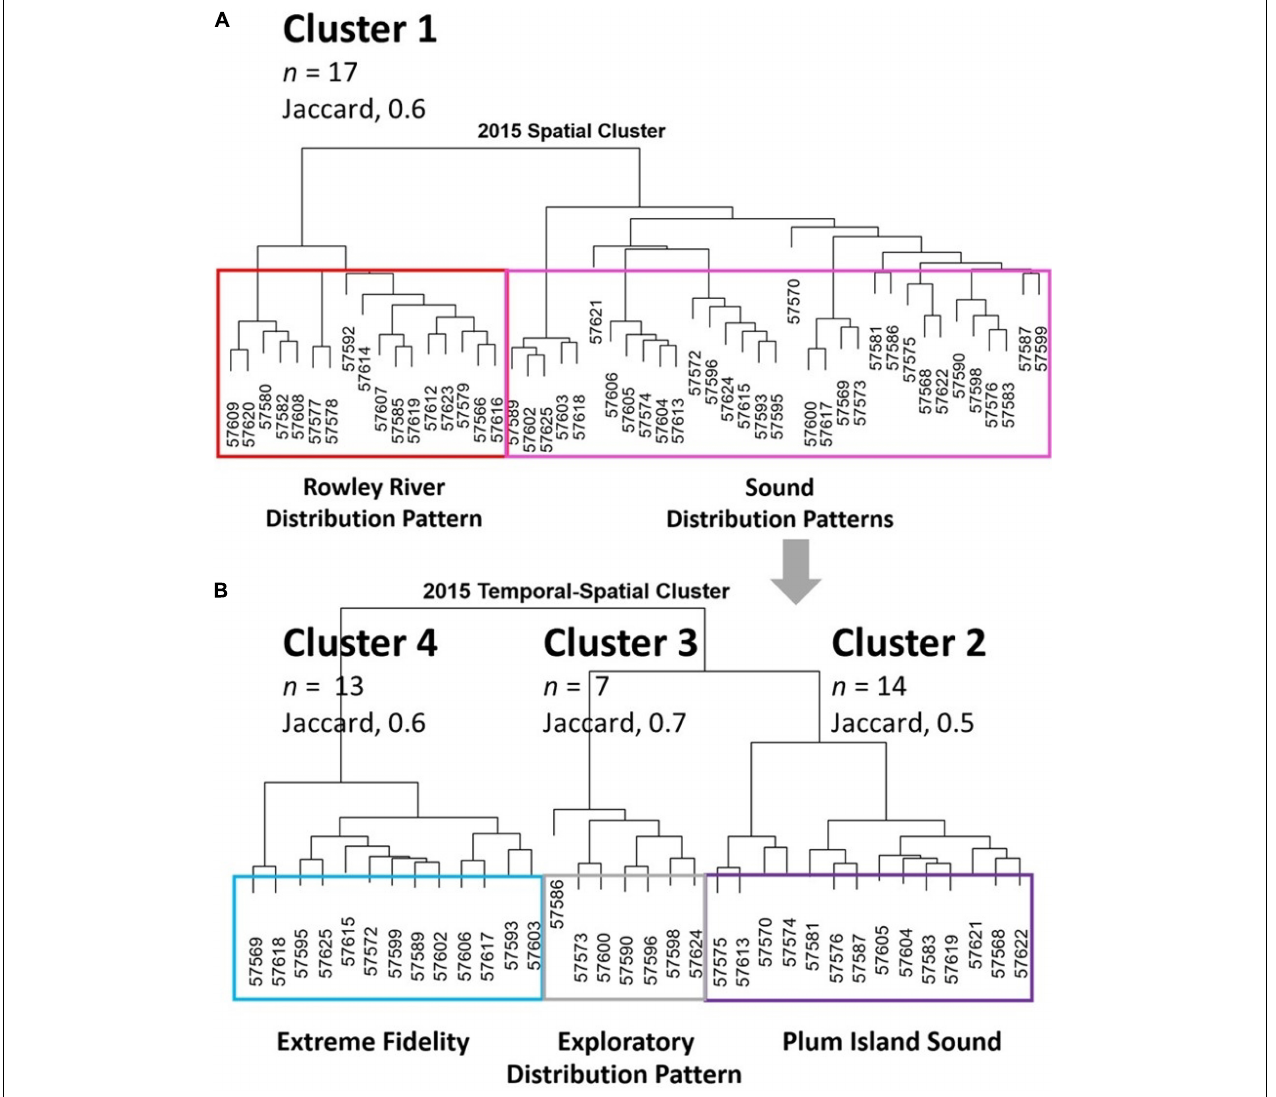
FIGURE 2 | Four distributional cluster groups are shown. (A) Spatial cluster dendrogram based on proportion of time spent at each of 26 receivers that identifies the Rowley River group (Cluster 1, red box). (B) Temporal-spatial dendrogram that identified Plum Island Sound, Exploratory, and Extreme Fidelity distributional groups (Clusters